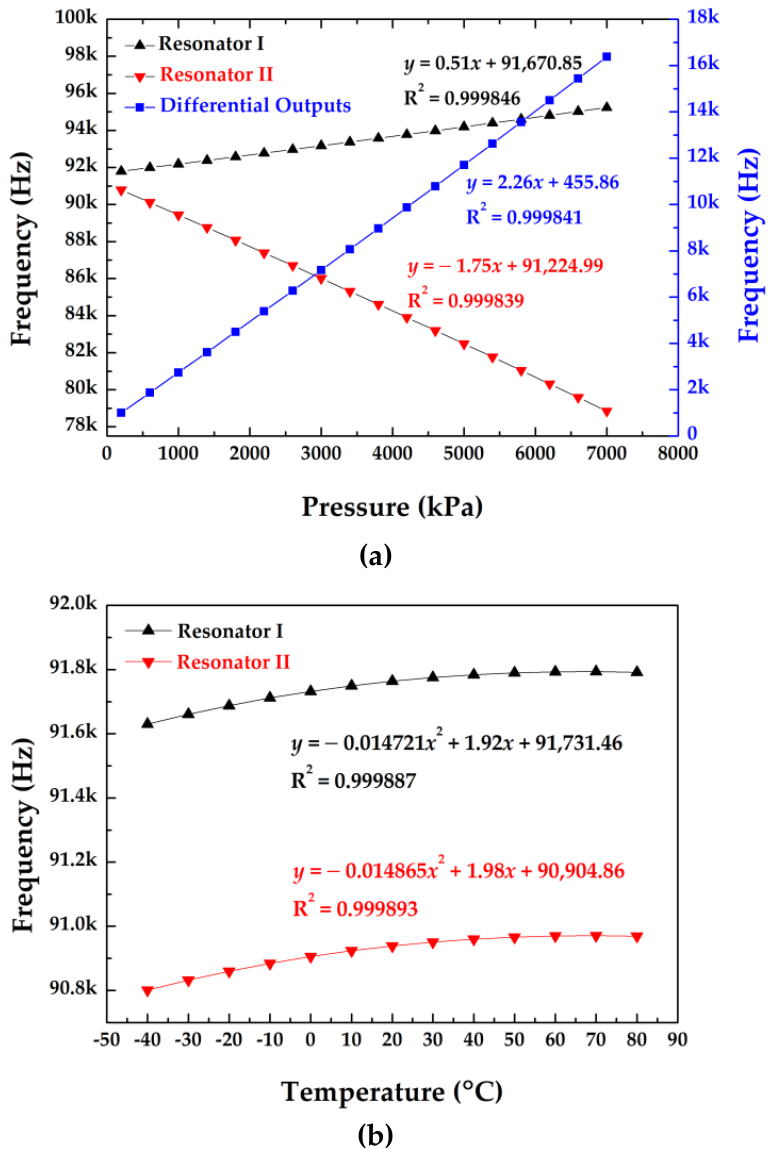
Figure 9. ( a ) The pressure–frequency curve of the developed sensor at 20 °C; ( b ) the temperature– frequency curve of the developed sensor under atmosphere pressure of ~ 100 kPa.